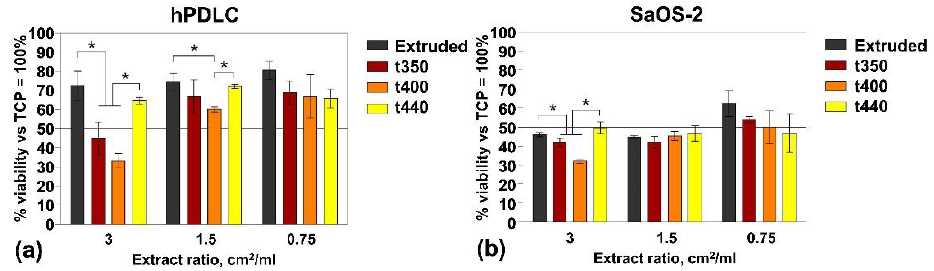
Figure 10. Viability of normal human PDL cells ( a ) and human bone osteosarcoma cell line SaOS-2 ( b ) cells exposed to different extracts ratios, harvested from MgCa alloys subjected to different modes of processing. * p < 0.05 compared between samples.